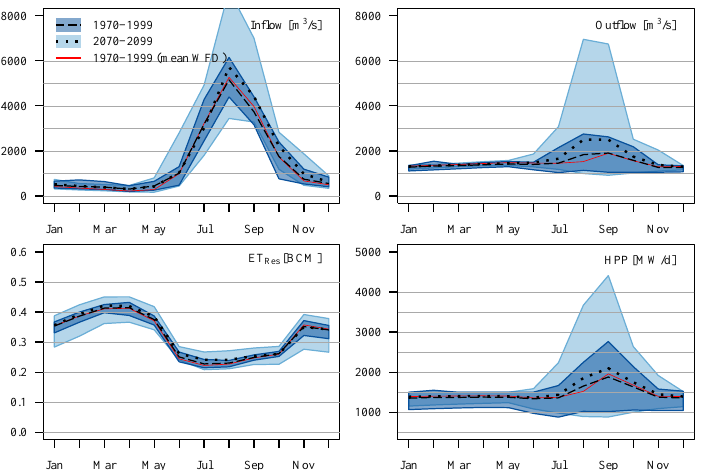
Figure 11. Range and mean of projected changes of inflows, outflows, ET Res and HPP using the model ensemble; RCP 8.5 (2070–2099), hpp_1500MW_01a